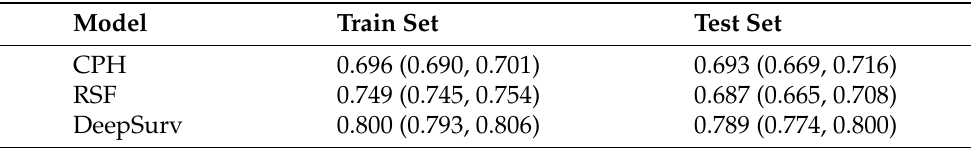
Table 3. Results of the concordance index (95% confidence interval) for all